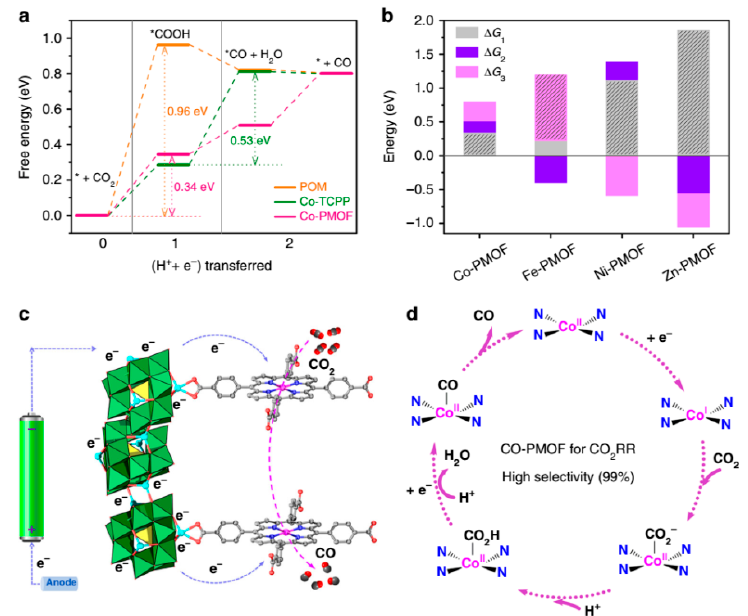
Figure 14. The DFT calculation and proposed reaction mechanism. The free energy diagrams CO 2 reduction reaction (CO 2 RR) for the Zn- ε -Keggin POM, the Co-TCPP metalloporphyrin and the Co-PMOF ( a ); comparison of the free energy of each elementary reaction ( ∆ G 1 , ∆ G 2 , and ∆ G 3 represent the free energy of * COOH formation, * CO formation, and CO desorption process, respectively) in CO 2 RR for Co-PMOF, Fe-PMOF, Ni-PMOF, and Zn-PMOF ( b ); proposed mechanistic scheme for the CO 2 RR on Co-PMOF ( c , d ); color code: MoO 6 octahedra, bottle green; Zn, light blue ball; Co, magenta ball, N, blue ball; C, grey ball; O, red ball. Reprinted with permission from [58]. Copyright © 2015 Attribution 4.0 International (CC BY 4.0).